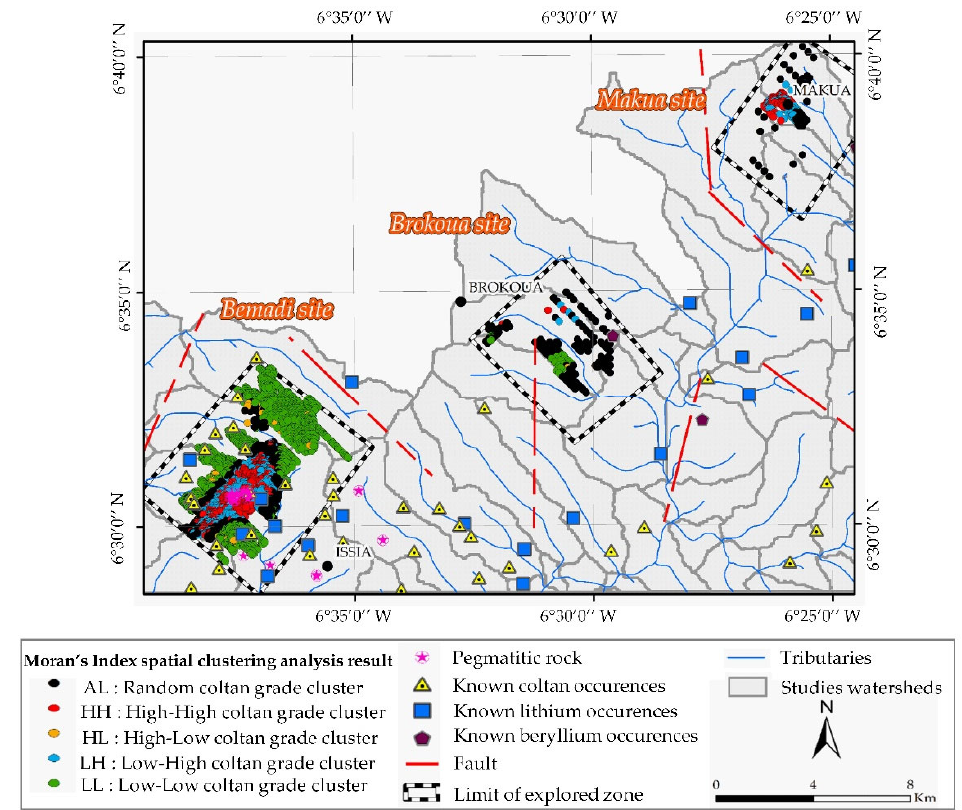
Figure 7. Map of spatial aggregates in the three different sites of the study area.